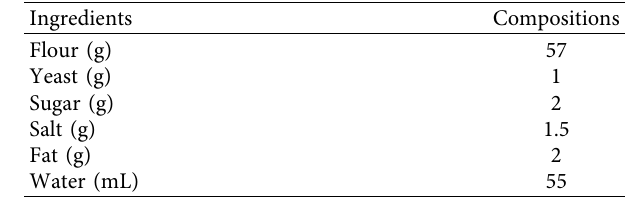
Table 2: Ingredient formulation to produce wheat, banana, and carrot-based breads.